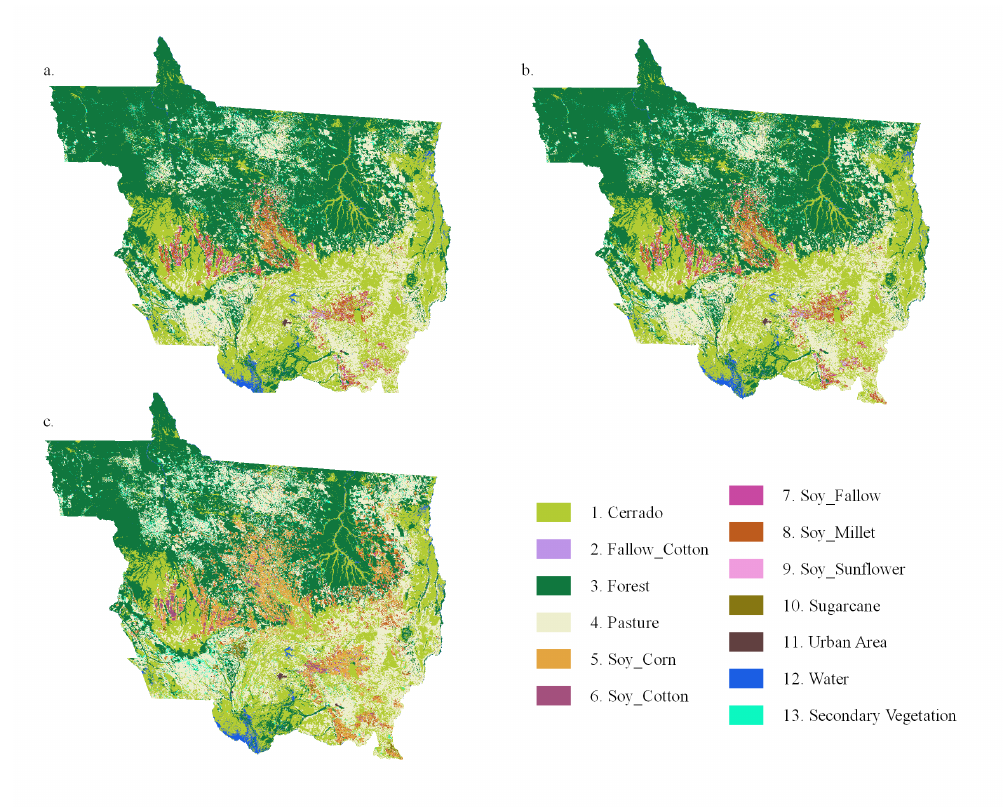
Figure 2. Classification map for the State of Mato Grosso in 2005, 2010, and 2017. Source: Camara et al.